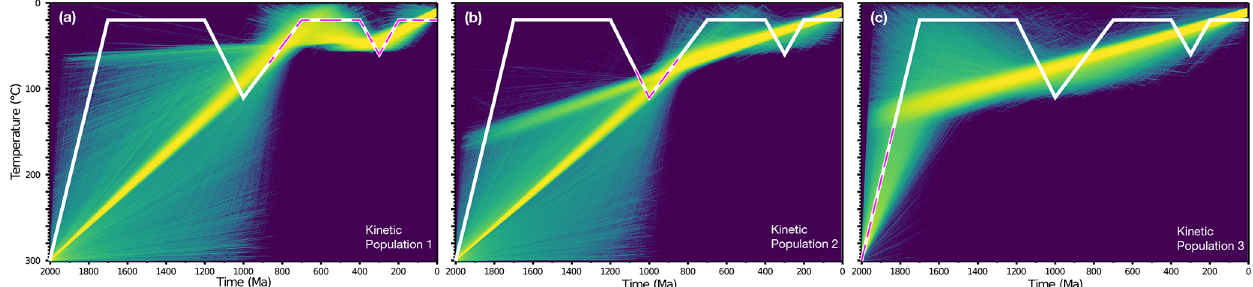
Figure 5. QTQt models of each individual AFT kinetic population plotted with respect to the true thermal history. (a) Kinetic population one. (b) Kinetic population two. (c) Kinetic population three. The magenta dashed line indicates the approximate t – T sensitivity of each kinetic population within the overall model history (also see Fig. 6b retention ages). The true kinetics were applied in each simulation. All other explicit boundary conditions are the same as previous